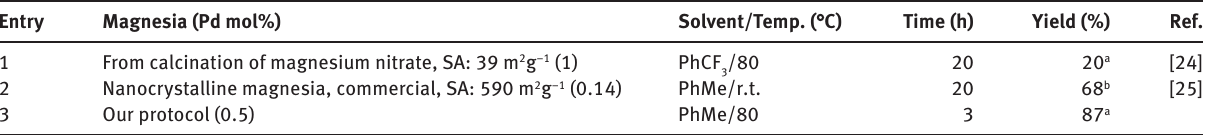
Table 3: Comparison of magnesia supported palladium nanoparticle catalysts for the aerobic oxidation of 1-octanol. Entry Magnesia (Pd mol%) Solvent/Temp. ( ° C) Time (h) Yield (%)